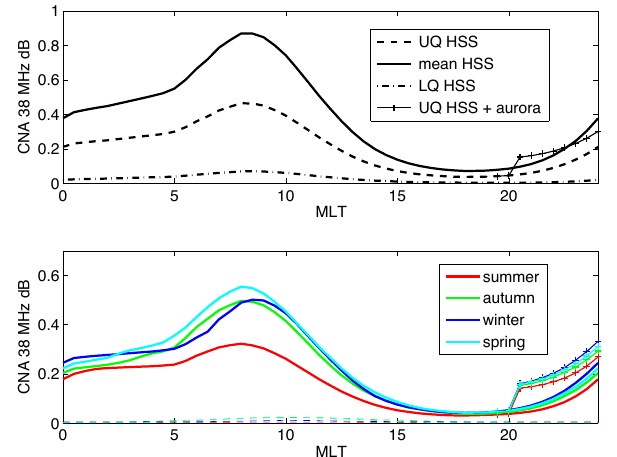
Figure 4. Averages of model calculations of cosmic-noise absorp- tion at 38MHz, for the location of Maitri Station, Antarctica. Top panel: annual averages for different EEP models – solid line for mean-HSS fluxes, dash-dot line for LQ-HSS and dashed line for UQ-HSS, with the addition of “aurora” fluxes to the UQ-HSS model in the 4h before magnetic midnight (solid lines with + , visible only close to the right-hand edge of the plot). Lower panel: seasonal av- erages for UQ-HSS fluxes (plain solid lines), with the addition of “aurora” fluxes in the 4h before magnetic midnight (solid lines with + ) and for the increase in absorption due to the HSS-associated NO increase, without any energetic electron precipitation (dashed